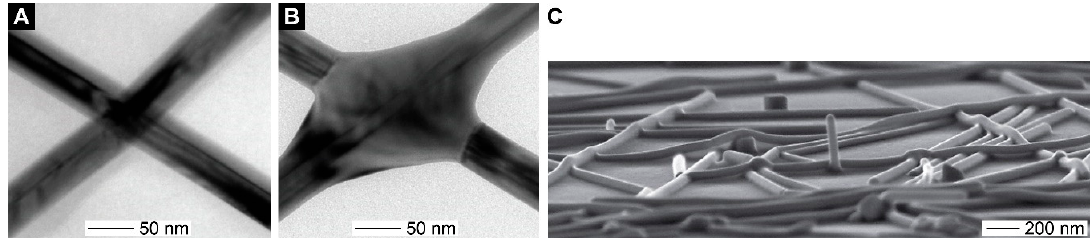
Figure 2. Electron micrographs of Ag nanowires before ( A ) and after ( B ) plasmonic welding, which causes the formerly stacked nanowires to merge. In the nanowire junction, the continuous twinning plane of one nanowire is maintained, while the second is thoroughly attached via recrystallization ( B ). ( C ) Tilted view of a merged 2D Ag nanowire film formed by plasmonic welding. Reprinted (adapted) with permission from [37]. Copyright (2012) Springer Nature Limited.